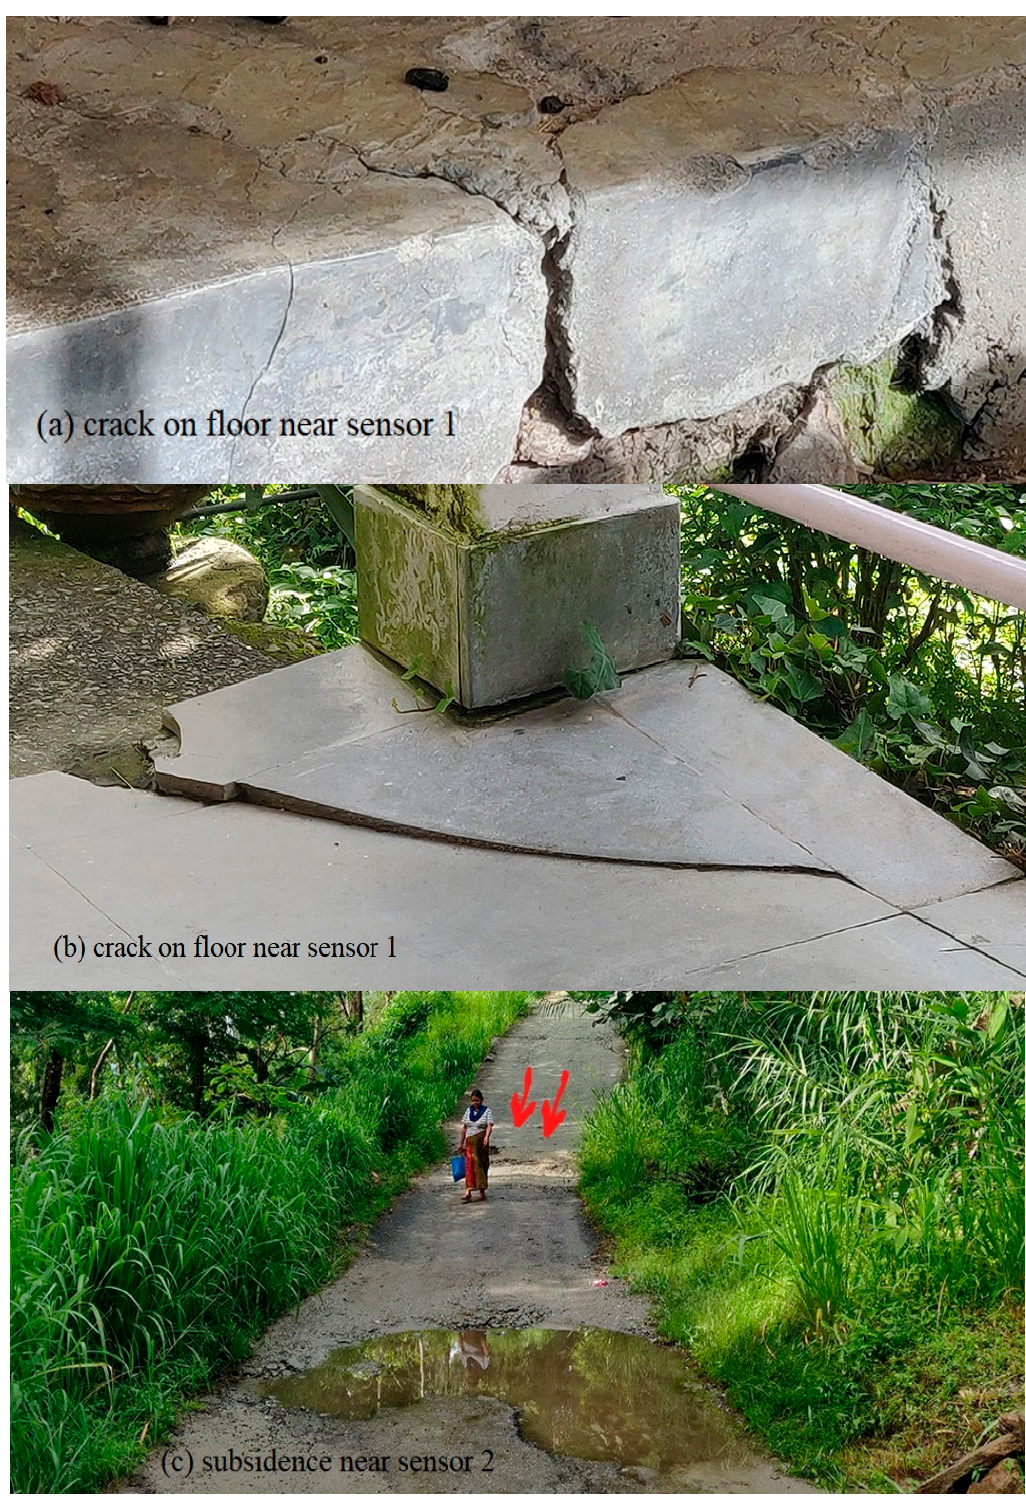
Figure 13. Displacements observed after the 2019 monsoon: ( a ) crack on floor near sensor 1, ( b ) crack on floor near sensor 1, ( c ) subsidence near sensor 2.